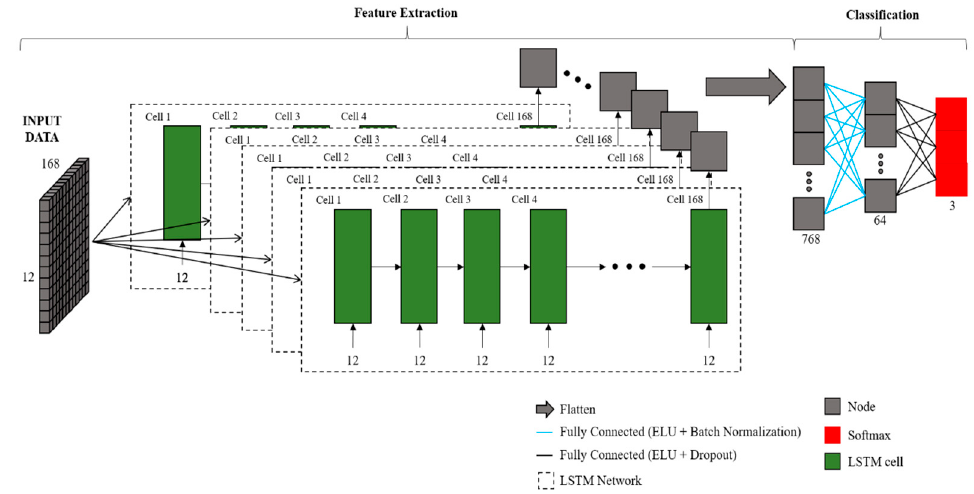
Figure 8. Recurrent neural network (RNN)-based model architecture.